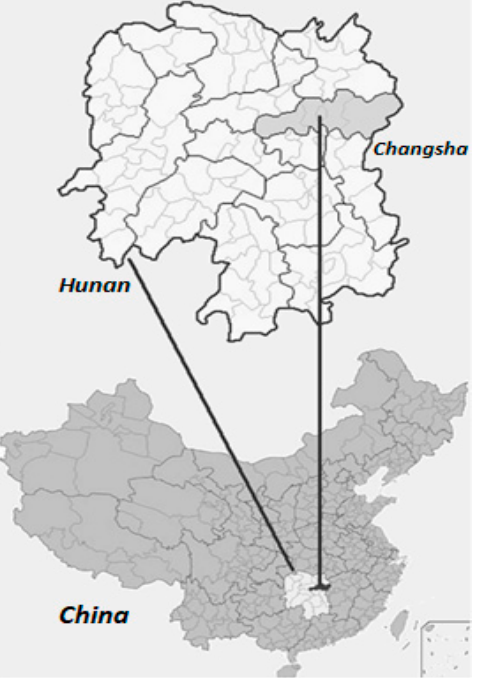
Figure 4. Location of the study area, Hunan botanical garden, Changsha, Hunan.